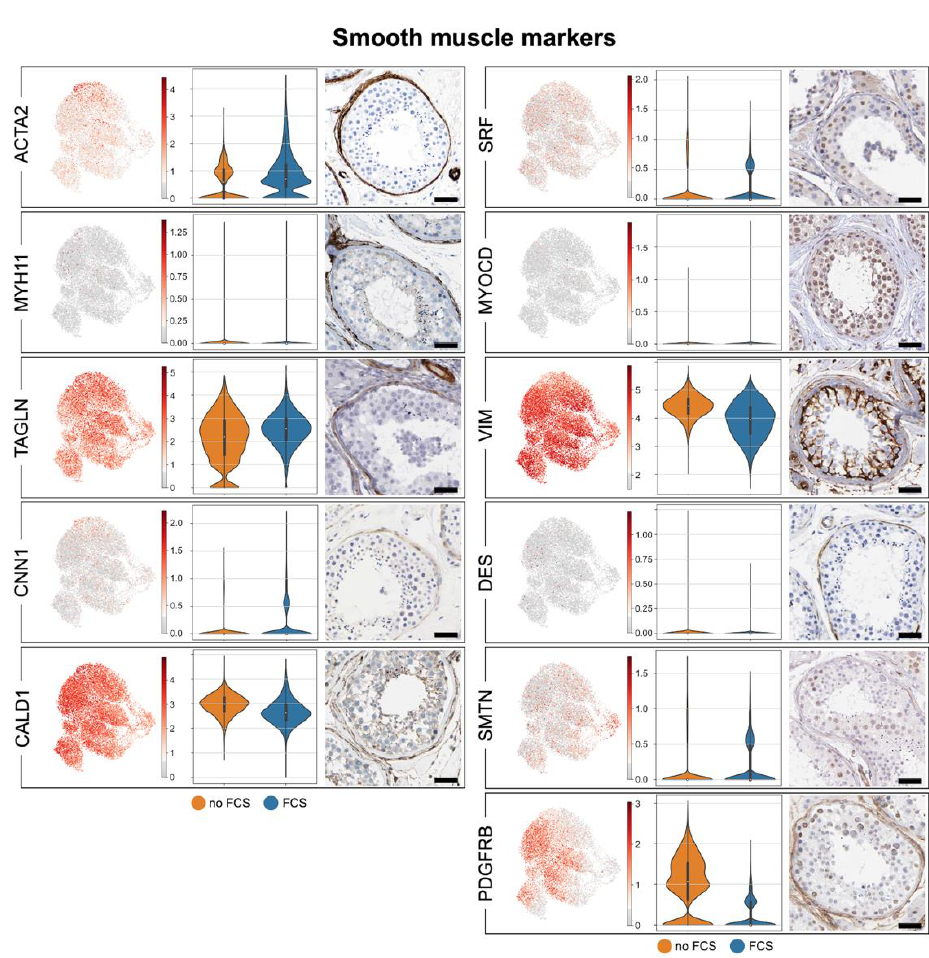
Figure 3. Smooth muscle markers. UMAP plots of prototype smooth muscle markers in HTPCs ( left side ). Violin plots comparing expression with and without FCS of HTPC-1 ( middle ) and corresponding protein detection with HPA images ( right side; scale bars = 50 µm). Please, note that abundances of some transcripts are affected by FCS. A comparison between HTPCs and ex vivo data is provided in Table 1. The markers shown here are also seen in testicular vascular SMCs; see Table A1 for links to the respective HPA images.